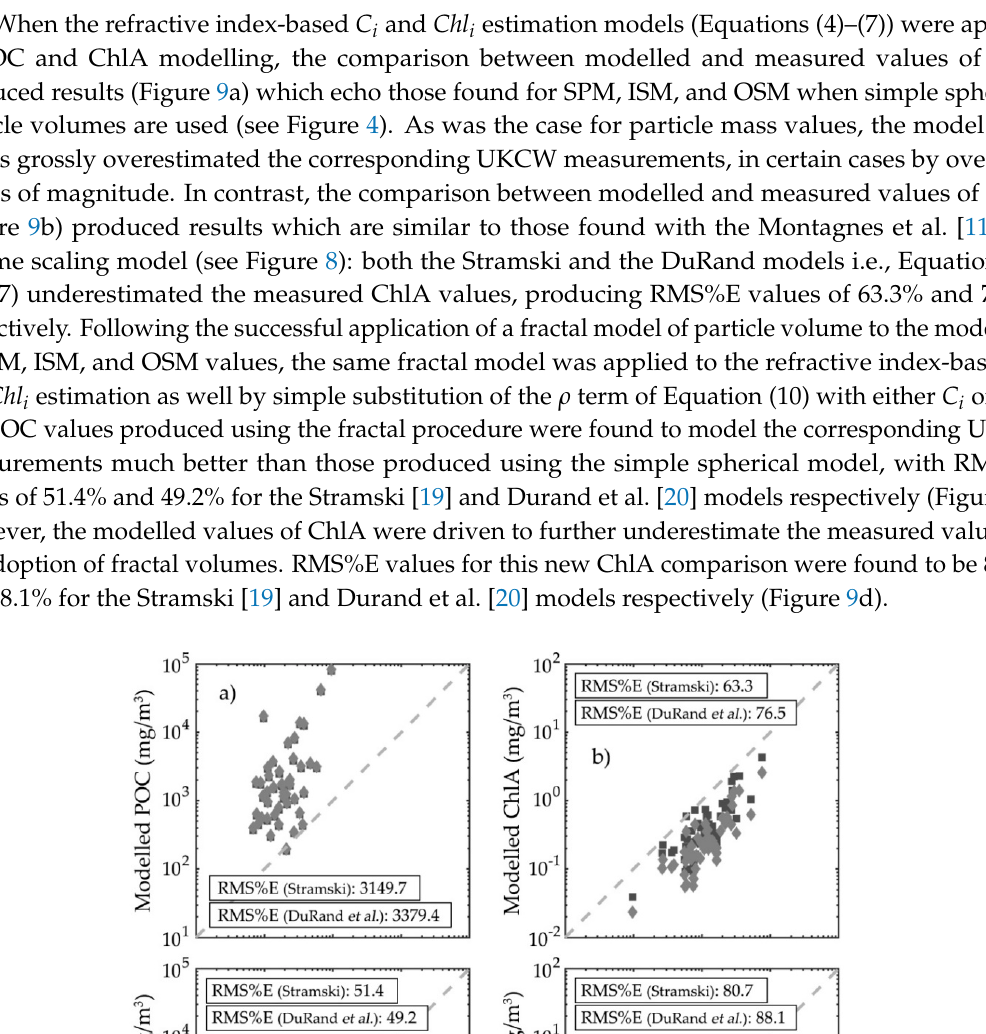
Figure 8. Comparison of modelled vs. measured ChlA. ChlA values calculated using the Montagnes et al. [11] model and the Álvarez et al. [13] model are represented by dark grey squares and light grey diamonds respectively. The dashed grey line indicates the 1:1 relationship.